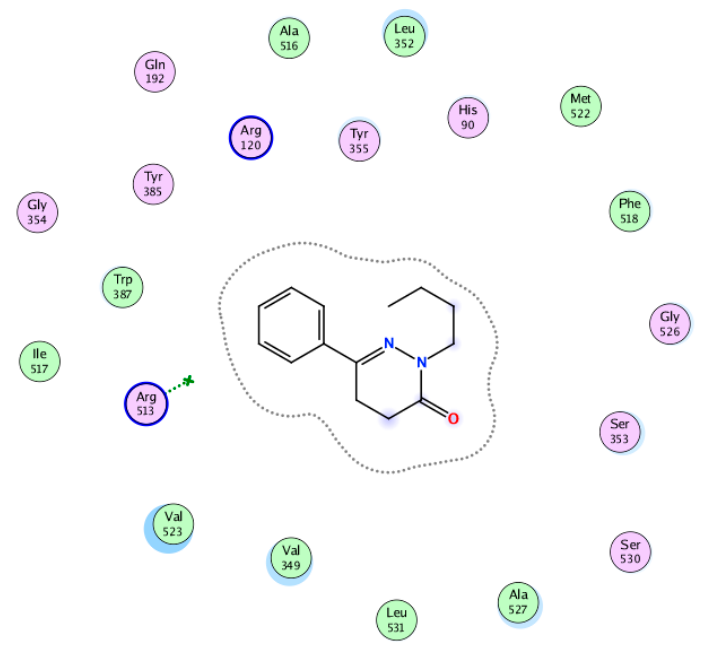
Figure 5. Interaction of compound 2 with COX-2 protein .